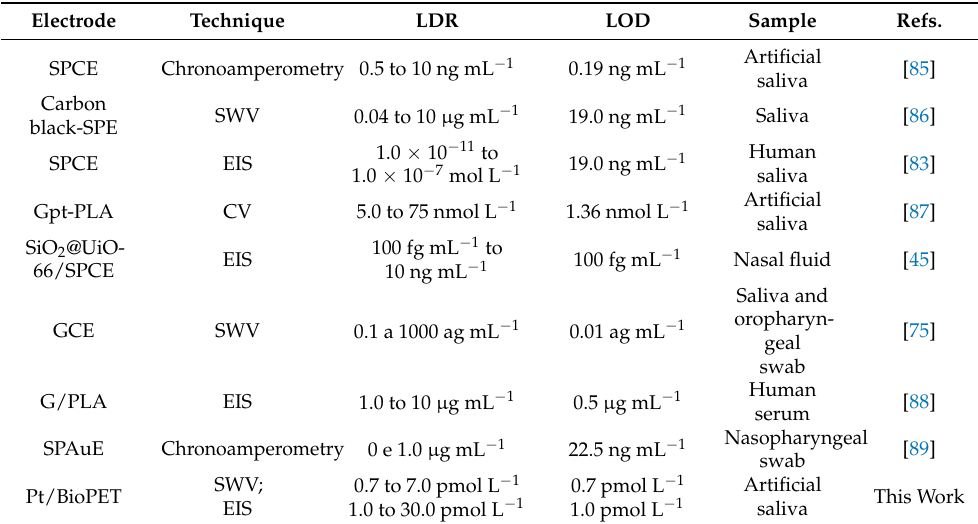
Table 1. Analytical performance of the flexible label-free platinum immunosensor for SARS-CoV-2 determination compared with the